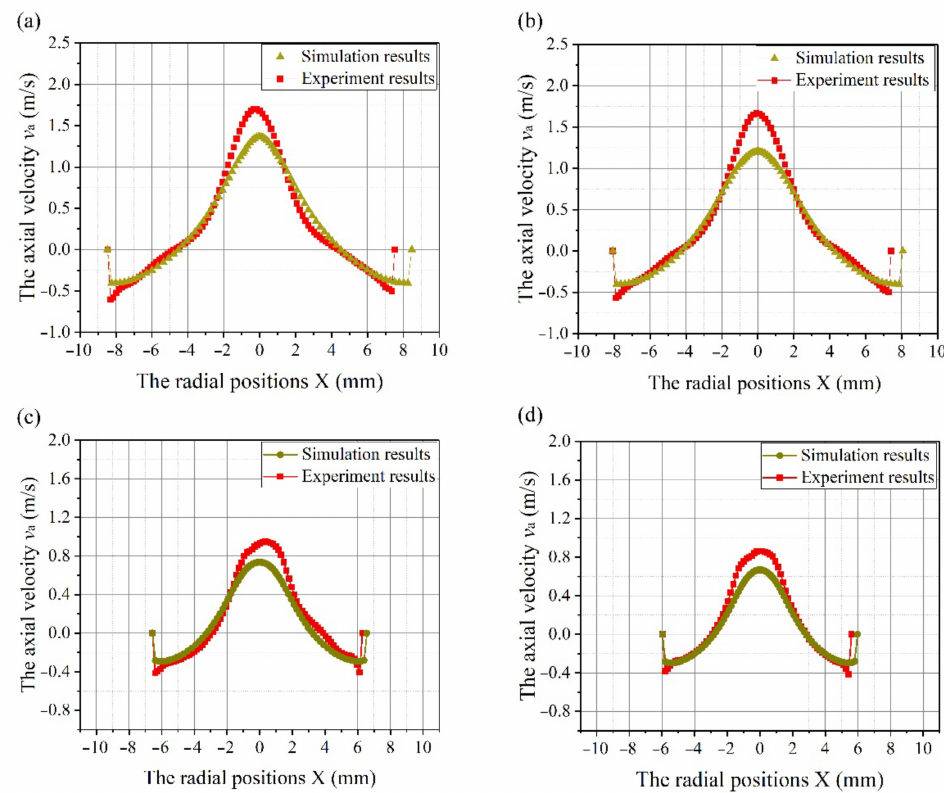
Figure 13. Comparisons of simulation and experimental results of the axial velocity. ( a ) Line 1; ( b ) Line 2; ( c ) Line 3; ( d ) Line